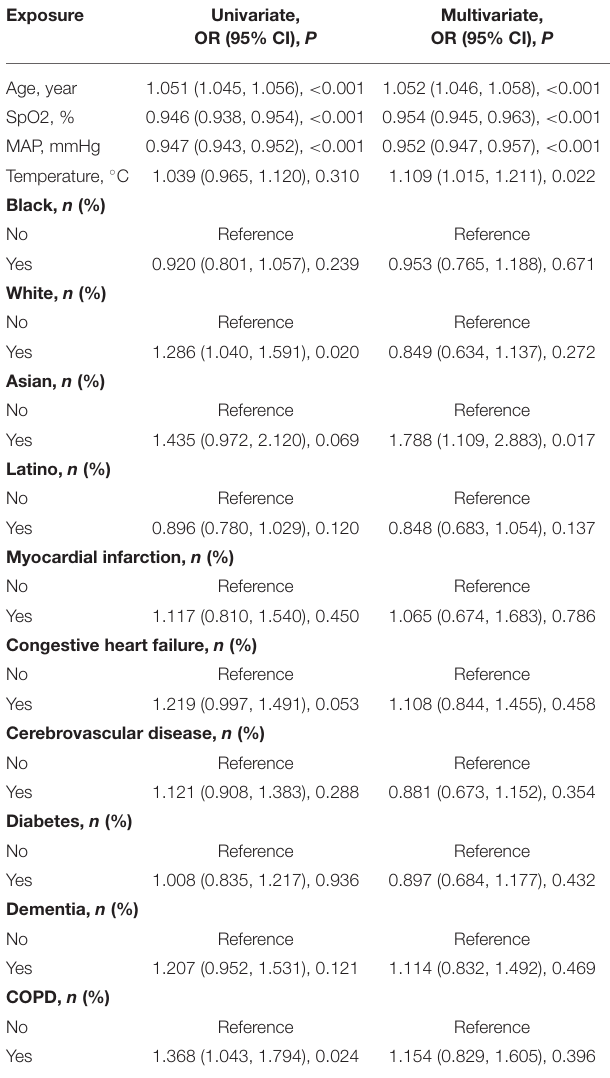
TABLE 2 | The results of univariate analysis and multivariate logistic regression analysis. Exposure